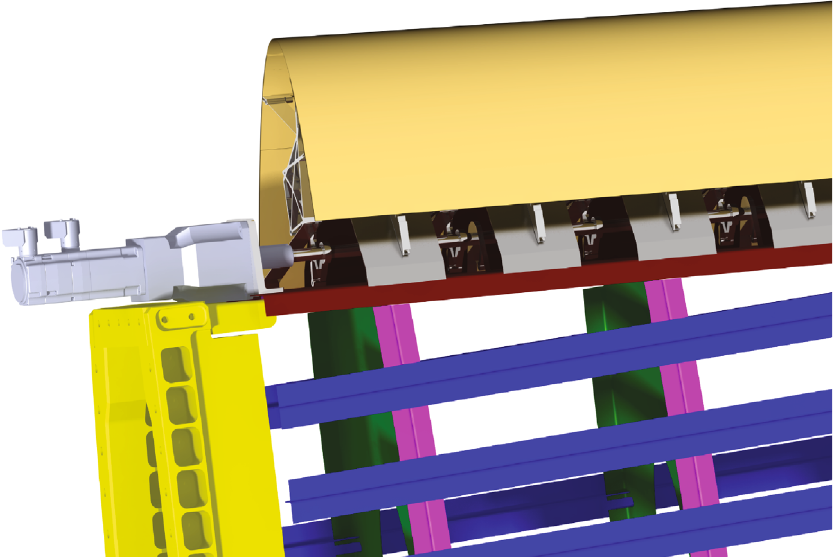
Figure 23: Assembly of the morphing droop nose and bottom accessibility.